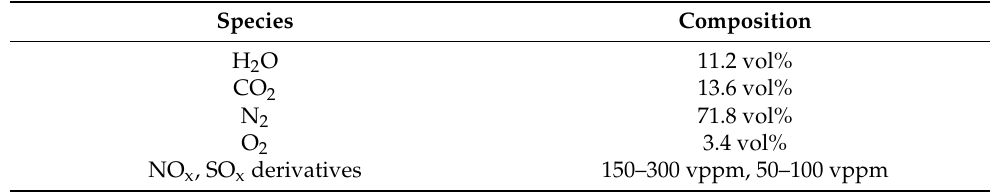
Table 1. Typical flue gas composition after flue gas desulfurization (FGD)